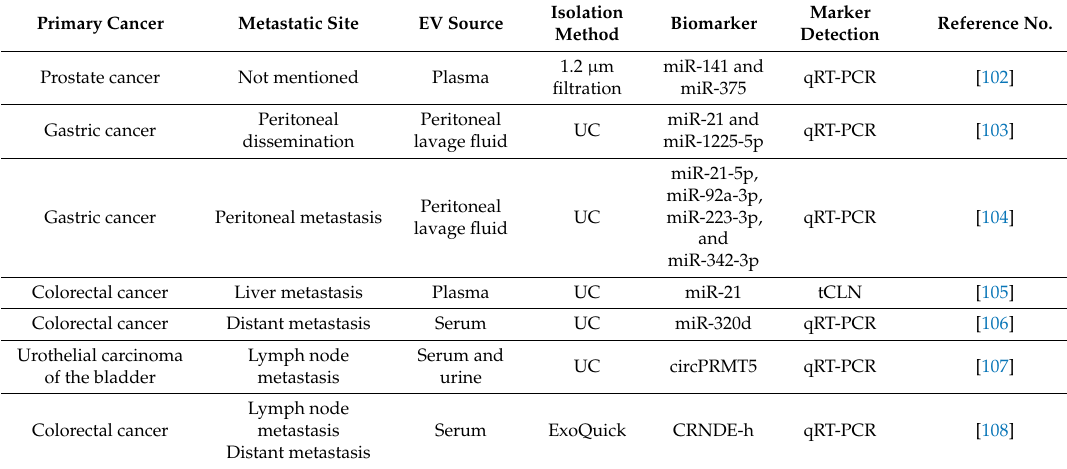
Table 1. Biomarkers for cancer metastasis in